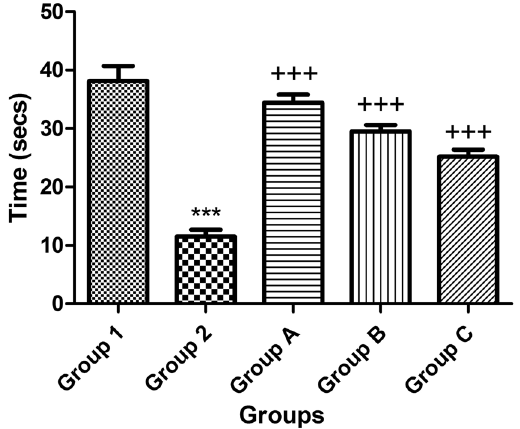
Figure 2. Effect of STZ, celecoxib, and gingerol (10 and 20 mg/kg) on the Morris water maze probe test. Animals were divided into 5 groups. Group 1 received a single dose of saline ICV; then, after 2 weeks, animals were intraperitoneally injected with saline for seven days. Group 2 received a single injection of STZ (3 mg/kg, i.c.v.), and then, after 2 weeks, they were intraperitoneally injected with saline for 7 days. Group A was injected with STZ (3 mg/kg, i.c.v.) once, and after 2 weeks, they were injected with celecoxib (30 mg/kg, i.p.) for 7 days. Group B animals were injected with STZ (3 mg/kg, i.c.v.) once, and after 2 weeks, they were injected with gingerol (10 mg/kg/day, i.p.) for 7 days. Group C was injected with STZ (3 mg/kg, i.c.v.) once, and after 2 weeks, they were injected with gingerol (20 mg/kg/day, i.p.) for 7 days. Animals from groups A, B, and C were subjected to the behavioral tests after the 3 rd week of injections. Each result represents the mean value for 10 mice ± SE of the mean. Statistical analysis was carried out by one-way ANOVA followed by a Tukey-Kramer multiple comparison test with the aid of GraphPad Prism Software version 5. *** Significantly different from the normal group P < 0.001. +++ Significantly different from the STZ group P < 0.001.